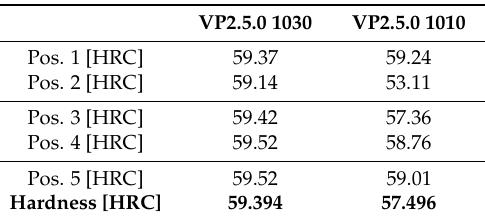
Table 6. Actual hardness values for both blanks of insert tests.